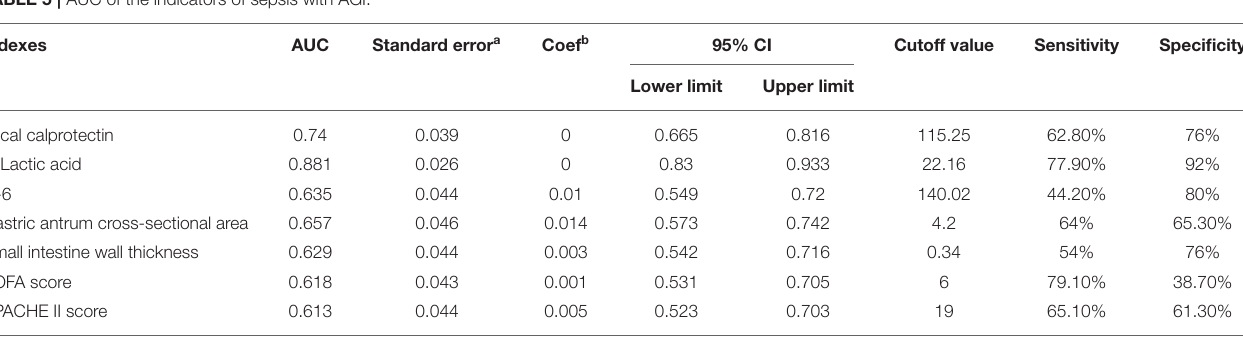
TABLE 5 | AUC of the indicators of sepsis with